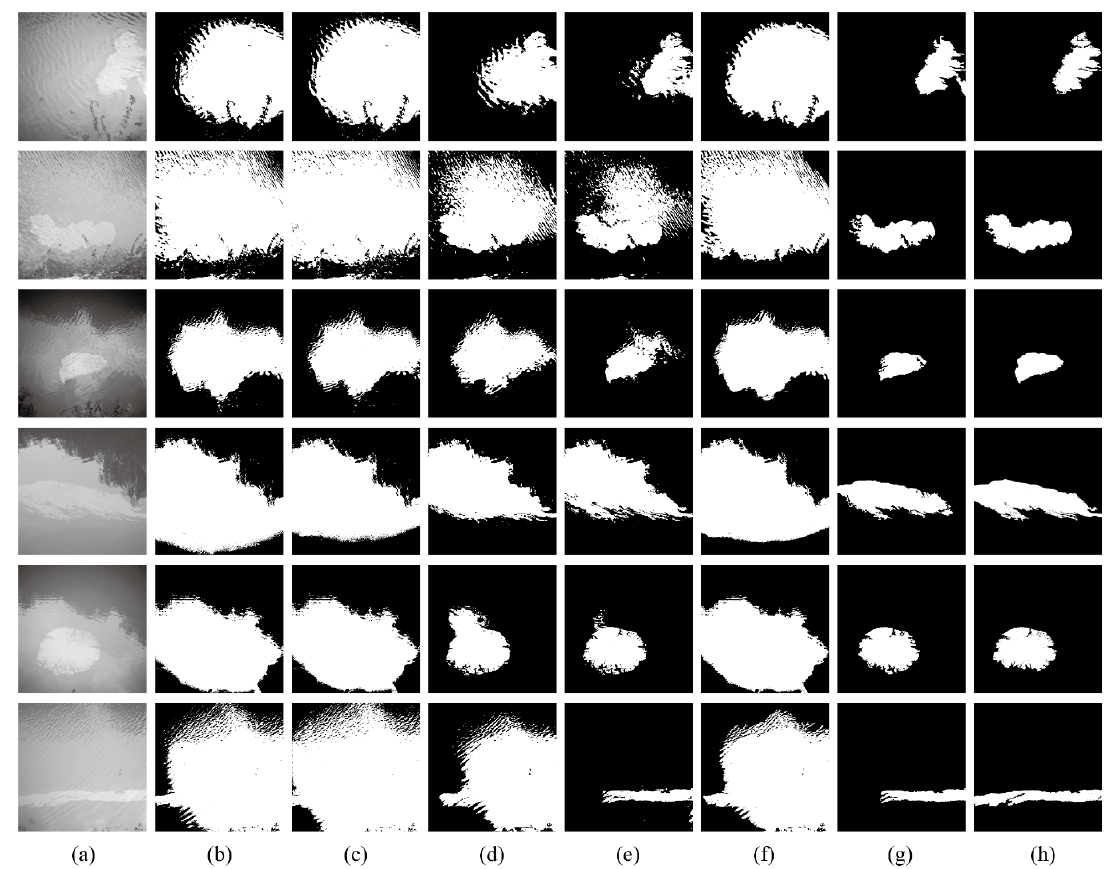
Figure 12. Comparison results. ( a ) Original image; ( b ) Otsu; ( c ) Max entropy; ( d ) LFTM with N cluster = 3; ( e ) LFTM with N cluster = 3; ( f ) Chan–Vese active contour model (CV model); ( g ) our method; and ( h ) ground-truth.